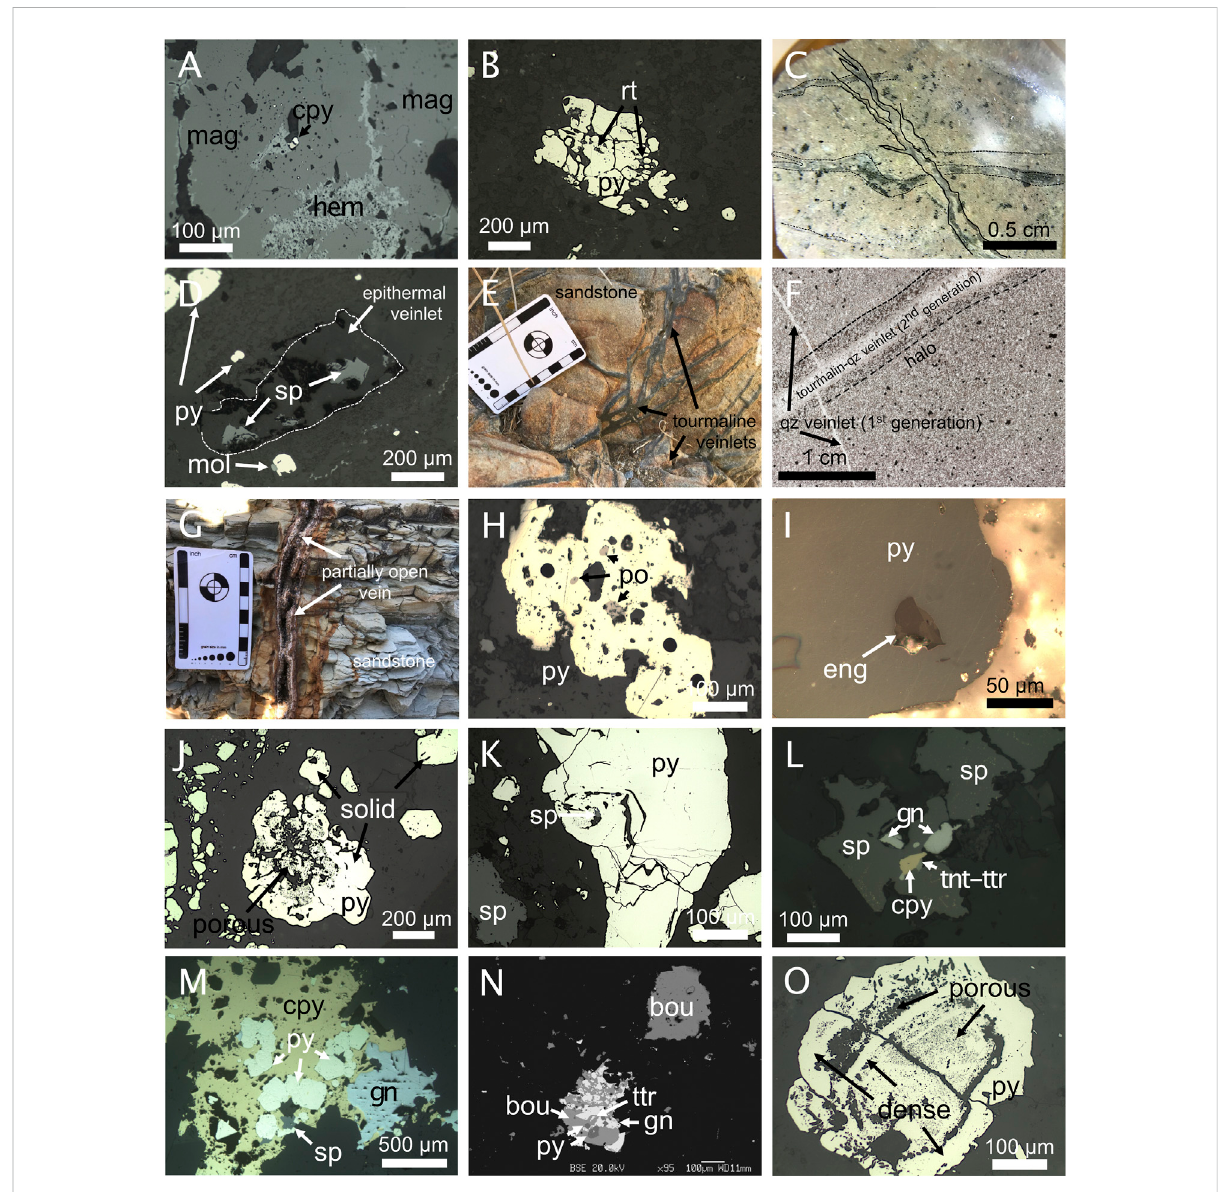
FIGURE 3 Field photographs, microphotographs and BSE image of Fakos samples: (A) Porphyry sample with chalcopyrite hosted by magnetite and hematite from the potassic alteration zone (LM-84); (B) Porphyry pyrite with rutile, LM-64; (C) Cross-cutting relationships of quartz veinlets in the porphyry stage, LM-64; (D) Porphyry pyrite and molybdenite from the sericitic alteration with later-stage epithermal sphalerite, we note that the crystal facets ofthepyrites may partly onlybevisibleunder highmagni fi cation; (E) Cross-cuttingrelationships ofsandstone-hosted transitional stage quartz-tourmaline veinlets (related samples: LM-JB-13, -14); (F) Scan of thin section with disseminated transitional pyrite in sandstone associated withtourmalineand differentgenerationsofquartzveinlets. Notethat pyriteisabsent inthealteration halosof1stgenerationquartz vein. (G) PartiallyopenveinswithcrustiformbandingofcarbonatesandFe-oxidesinsandstonesfromthetransitionalstage,LM-JB-03; (H) Slightlyporous pyrite(LM-JB-14)withpyrrhotiteinclusionsfromthetransitionalstage; (I) EnargiteinpyriteincrosspolarizedlightfromtheepithermalHSstage,LM- 29; (J) Pyrite with dense and porous domains with smaller dense pyrite crystals, LEM-29; (K) Dense slightly brecciated pyrite associated with sphalerite, LM-29; (L) Galena, chalcopyrite and tetrahedrite-tennantite associated with sphalerite hosting chalcopyrite inclusions from the epithermal IS stage, LM-27; (M) Pyrite surrounded by chalcopyrite followed by later-stage galena and sphalerite surrounding chalcopyrite in the epithermalISstage,LM-33a; (N) Pyriteassociatedwithgalena,bournoniteandAg-richtetrahedriteinback-scatteredelectroncontrast,LM-27B;